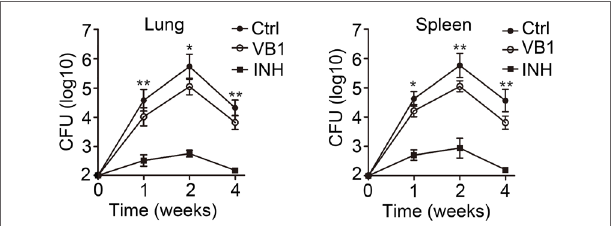
FigUre 1 | The anti-bacillus effect of vitamin B1 (VB1) in mice with Mycobacterium tuberculosis infection. C57BL/6J mice were infected with H37Rv (~200 bacteria/mouse). Oral administration with water (Ctrl), VB1, and INH ( n = 15 mice/group) was started from the day after infection (day 1) and continued for 1, 2, and 4 weeks alternatively. The lungs and spleens were analyzed at indicated time. Colony-forming units (CFUs) were obtained from the lung and spleen cell lysates by serial dilution and plating on 7H10 agars in triplicate. The colonies were counted after 4 weeks. Data shown are the mean ± SD. * P < 0.05 and ** P < 0.01. Data are representative of three independent experiments with similar